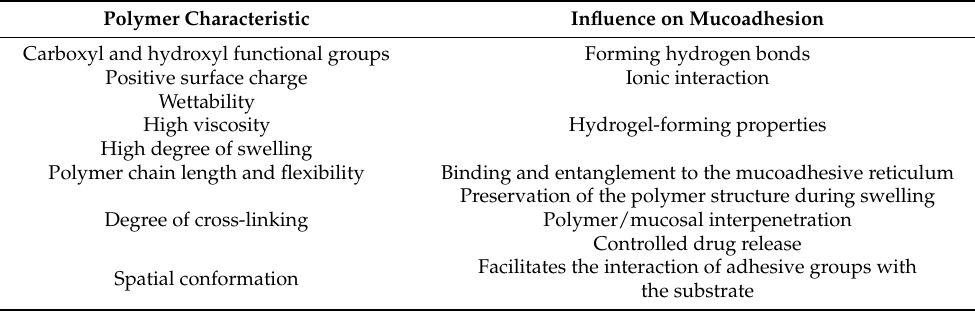
Figure 3. Illustration of various bioadhesion mechanisms. Mucoadhesive polymers must have specific characteristics (Table 3), such as hydrogen bonding functional groups, a positive surface charge, optimal wettability, high viscosity, and a high degree of swelling (hydrogel-forming properties), as well as high flexibility of the polymer chain for binding and entanglement to the mucoadhesive reticulum [59]. Table 3. Factors that increase bioadhesion of polymeric